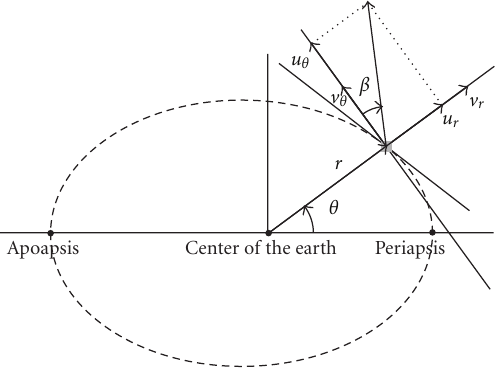
Figure 1: Definition of the polar